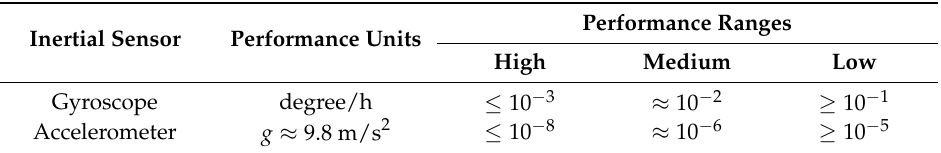
Table 2. Inertial sensor performance